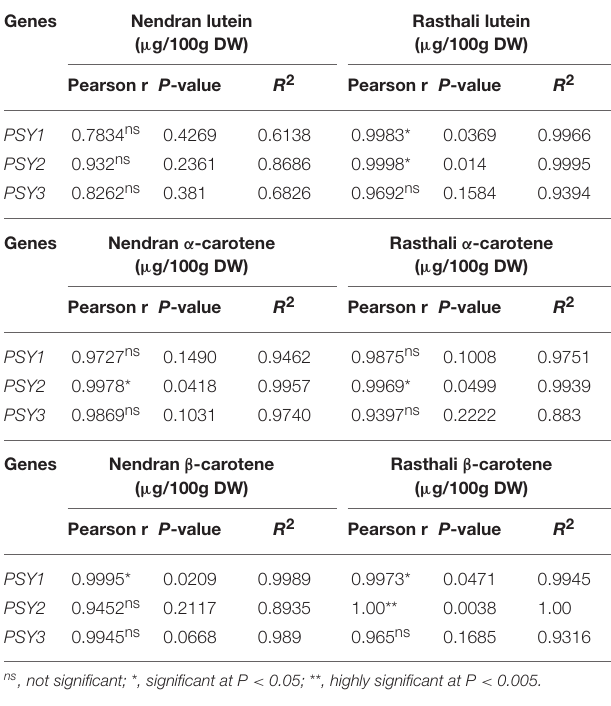
TABLE 2 | Correlation of PSY expression with the accumulation of individual carotenoids in fruit-pulp of Nendran and Rasthali. Genes Nendran lutein ( µ g/100g DW) Pearson r P -value